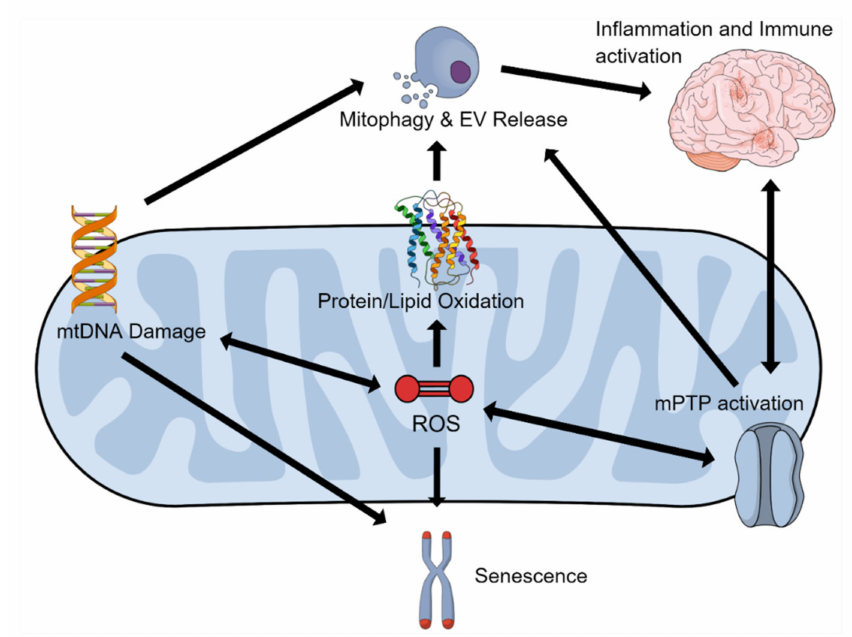
Figure 2. The Effects of ROS on Mitochondrial Function. An overview of the effects that generation of reactive oxygen species (ROS), classically associated with aging, have on mitochondrial function and DNA (mtDNA). Abbreviations: Extracellular vesicles, EV; mitochondrial permeability transition pore,